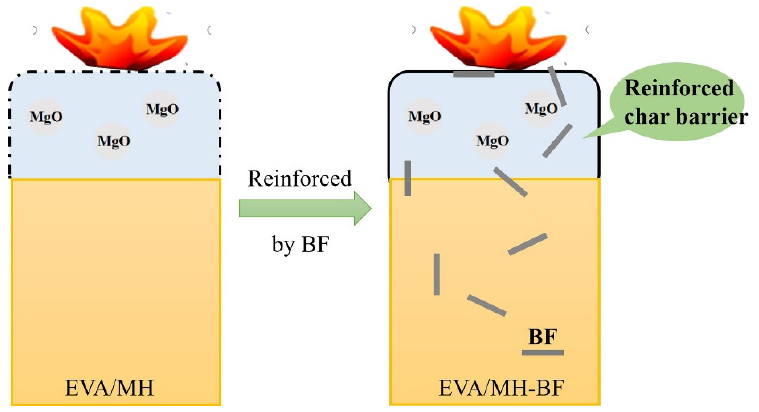
Figure 7. Schematic diagram of combustion of EVA composites.